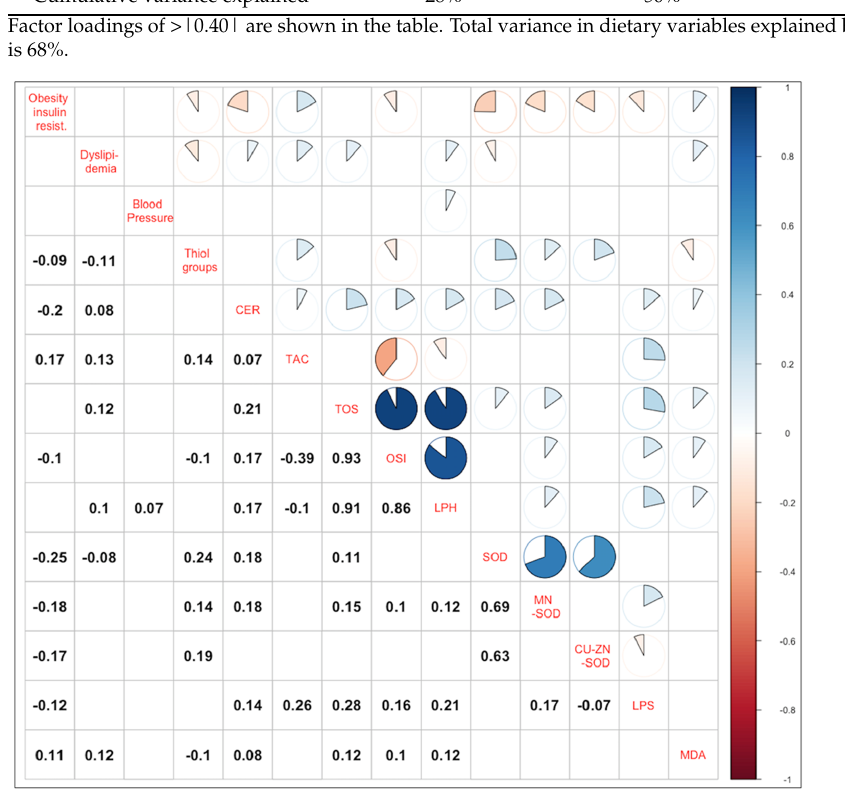
Figure 2. Correlation between main components and OS parameters. In the upper part of the plot, correlation coefficients between variables are presented in the form of a pie-chart. In the lower part of the plot, Spearman correlation coefficients are given. For clarity only, correlation coefficients with p -value < 0.05 are presented. CER—ceruloplasmin; TAC—total antioxidant capacity; TOS—total ox- idative status; OSI—oxidative stress index; LPH—lipid hydroperoxides; SOD—superoxide dis- mutase; MnSOD—manganese-containing superoxide dismutase; CuZnSOD—copper- and zinc- containing superoxide dismutase; LPS—lipofuscin; MDA—malondialdehyde.